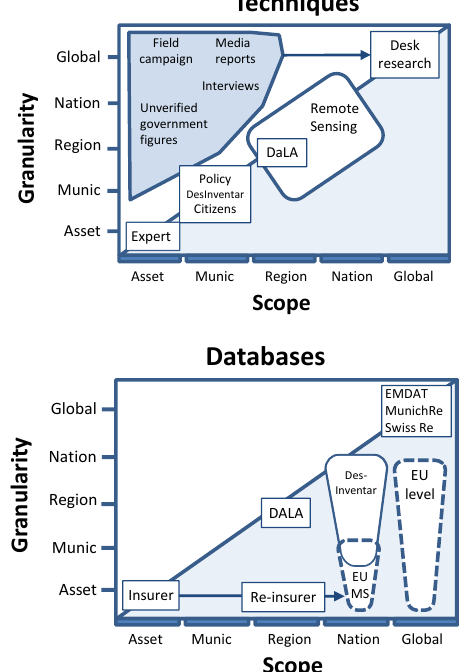
Figure 2. Scatter plots illustrating scope and granularity of information for loss data collection techniques and databases (modified from De Groeve et al., 2013).